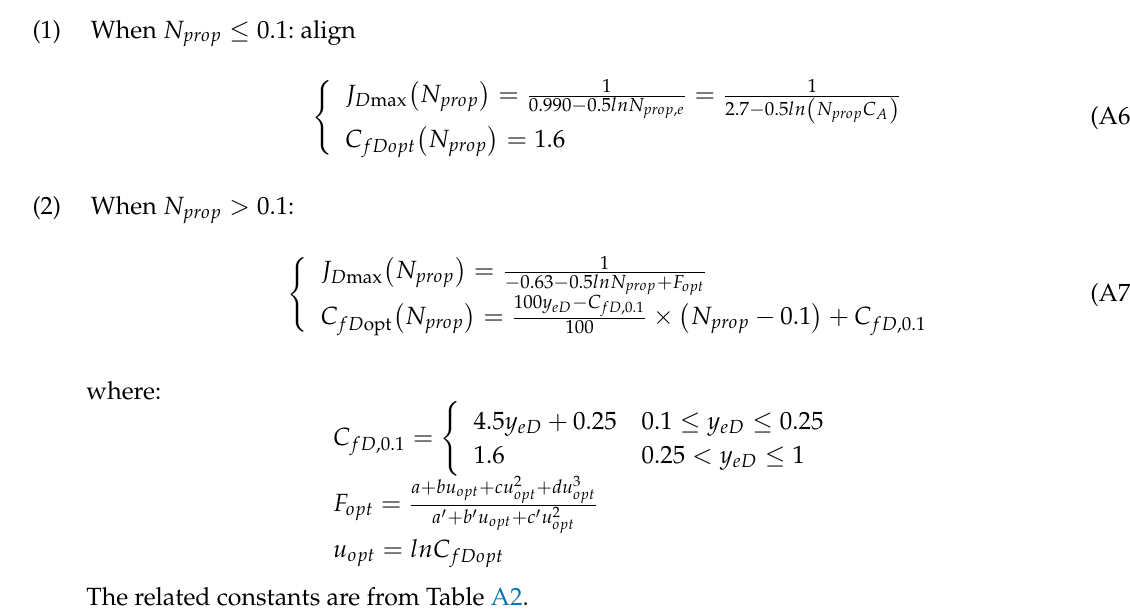
Table A2. Constants in F